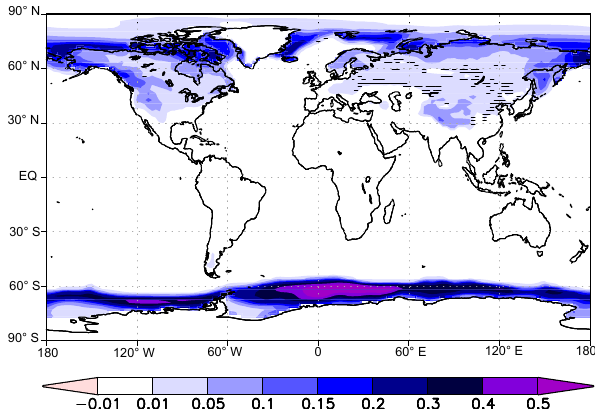
Figure 6. Differences between the NONSPH and SPH experiments in annual-mean snow fraction on land and in sea ice cover. Hatching indicates differences that exceed the threshold for colour shading (0.01) but are not significant at the 5%